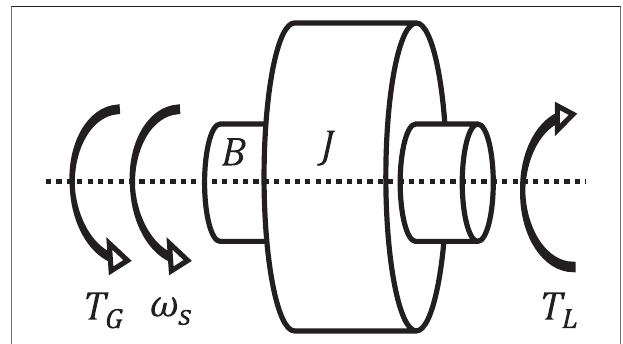
FIGURE 3 | Ideal representation of the electric grid as a rotating mass with inertia and